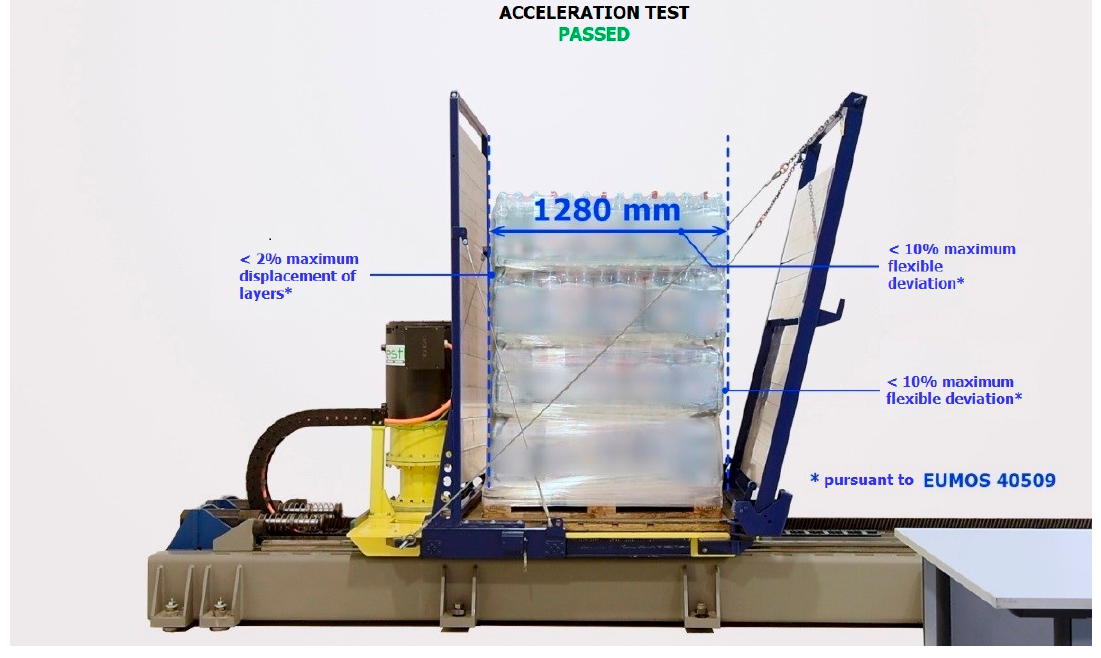
Figure 3. Horizontal stability tester for tests according to EUMOS 40509.